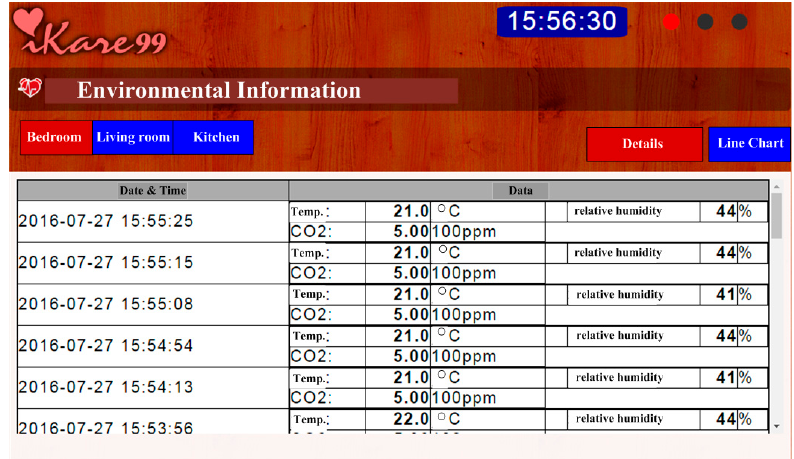
Figure 7. The measured data, including temperature, CO 2 and humidity concentration, received from the developed indoor environmental sensing platform can be transferred to a cloud server and browsed from a website.